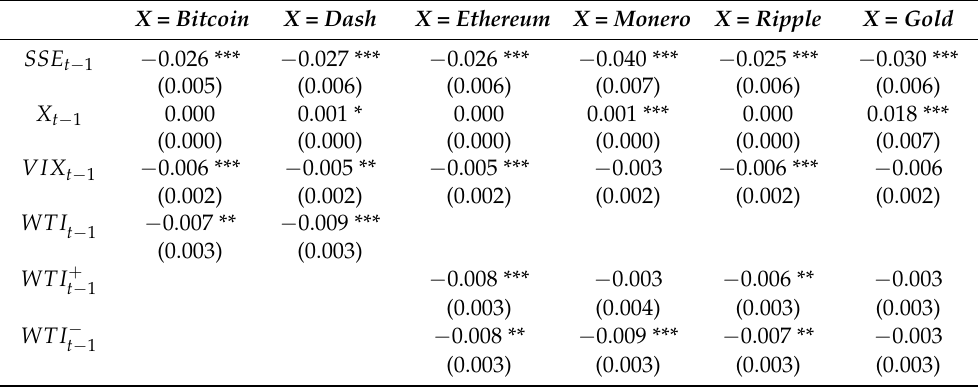
Table 8. Estimation results for SSE before